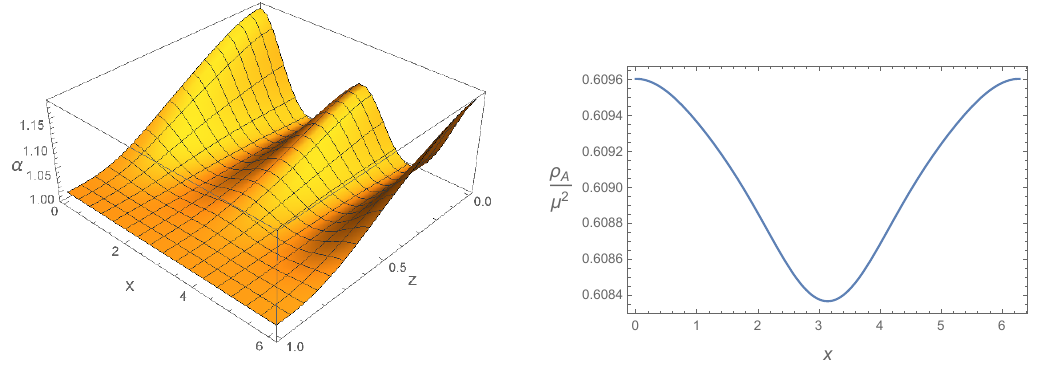
Figure 10 . Pro(cid:12)le for the gauge (cid:12)eld (cid:11) (left panel) and charge density (cid:26) A (right panel) for T = 0 : 01426 and k = 1, for the parameters chosen in (5.1) and q B = 0 : 5.